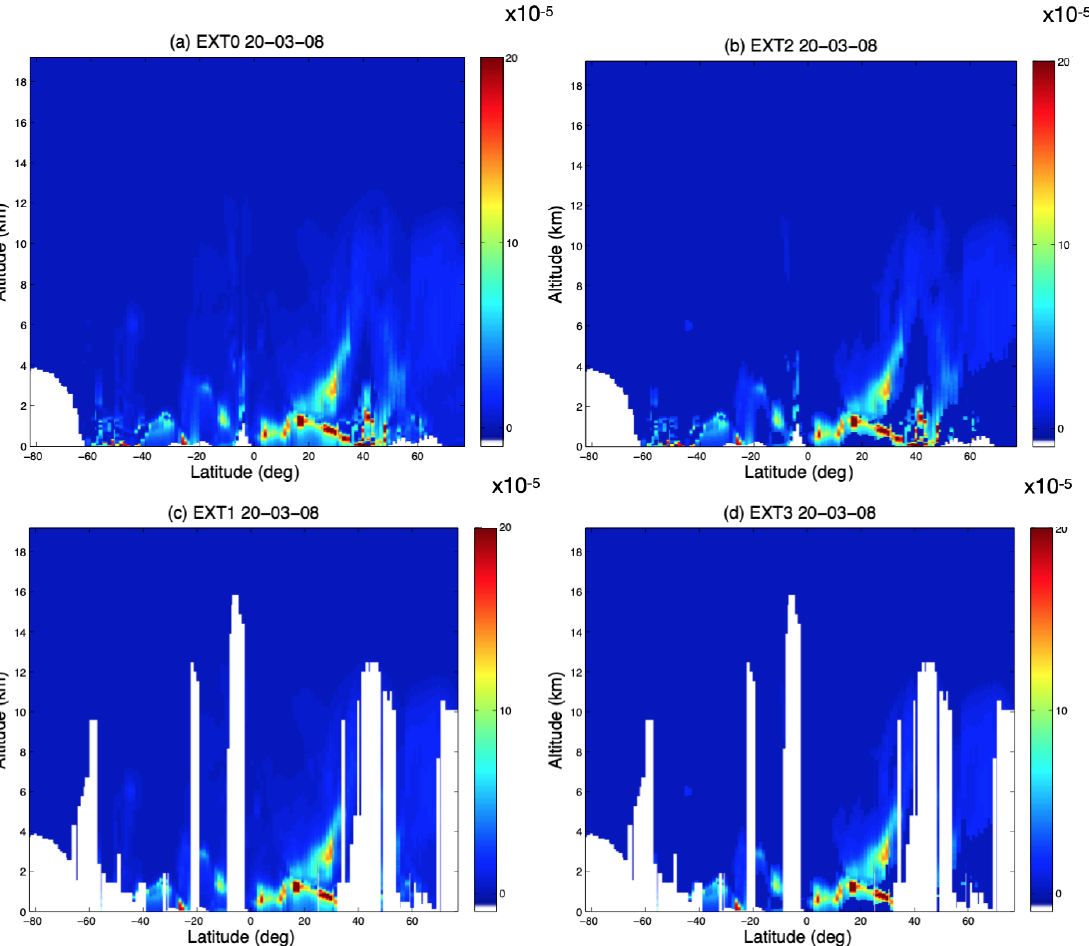
Figure 4. Total extinction vertical profiles (m − 1 ) defined on 320 levels and calculated by the COSPv2 simulator along the satellite orbit on 20 March 2008: (a) initial profiles; (b) profiles with the instrument aerosol detection threshold; (c) cloud-screened profiles; (d) cloud-screened profiles with the aerosol detection threshold